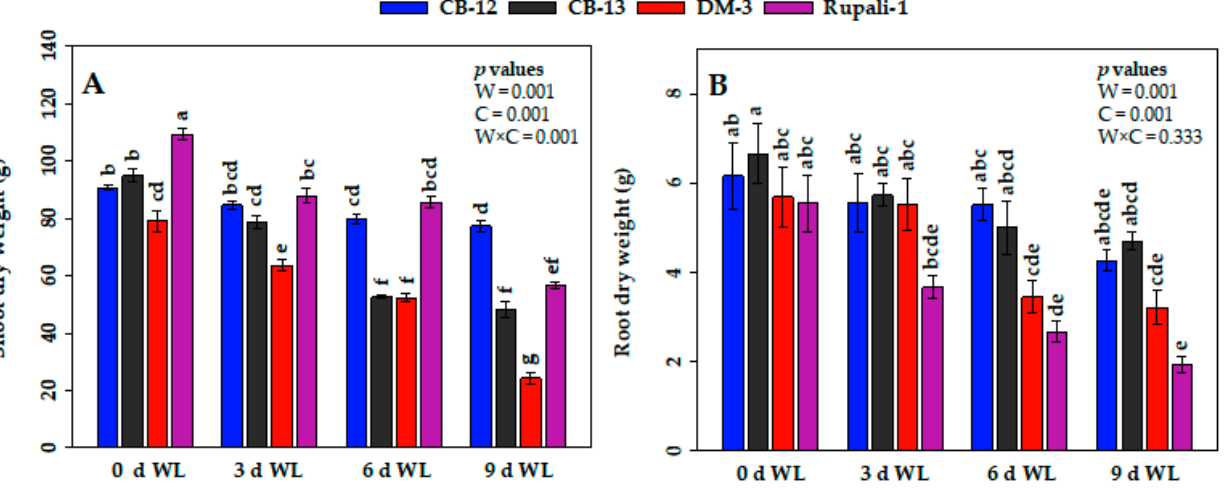
Figure 2. Effect of waterlogging (WL) on ( A ) shoot dry weight and ( B ) root dry weight. Values are means ± standard errors. Bars connected with different letters have significant differences. p values are presented at the top right corner of the graphs. W = WL duration, C = cotton cultivar, and W × C = interaction of WL duration and cotton cultivar. d; day(s).